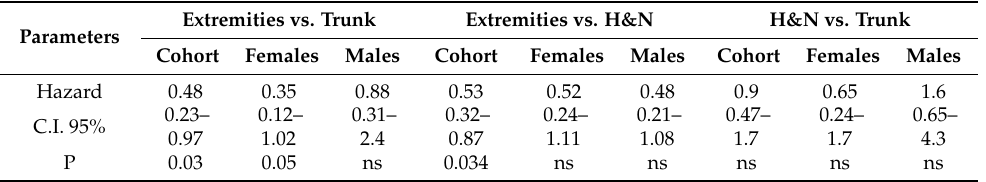
Table 2. Overall survival comparison between primary tumor